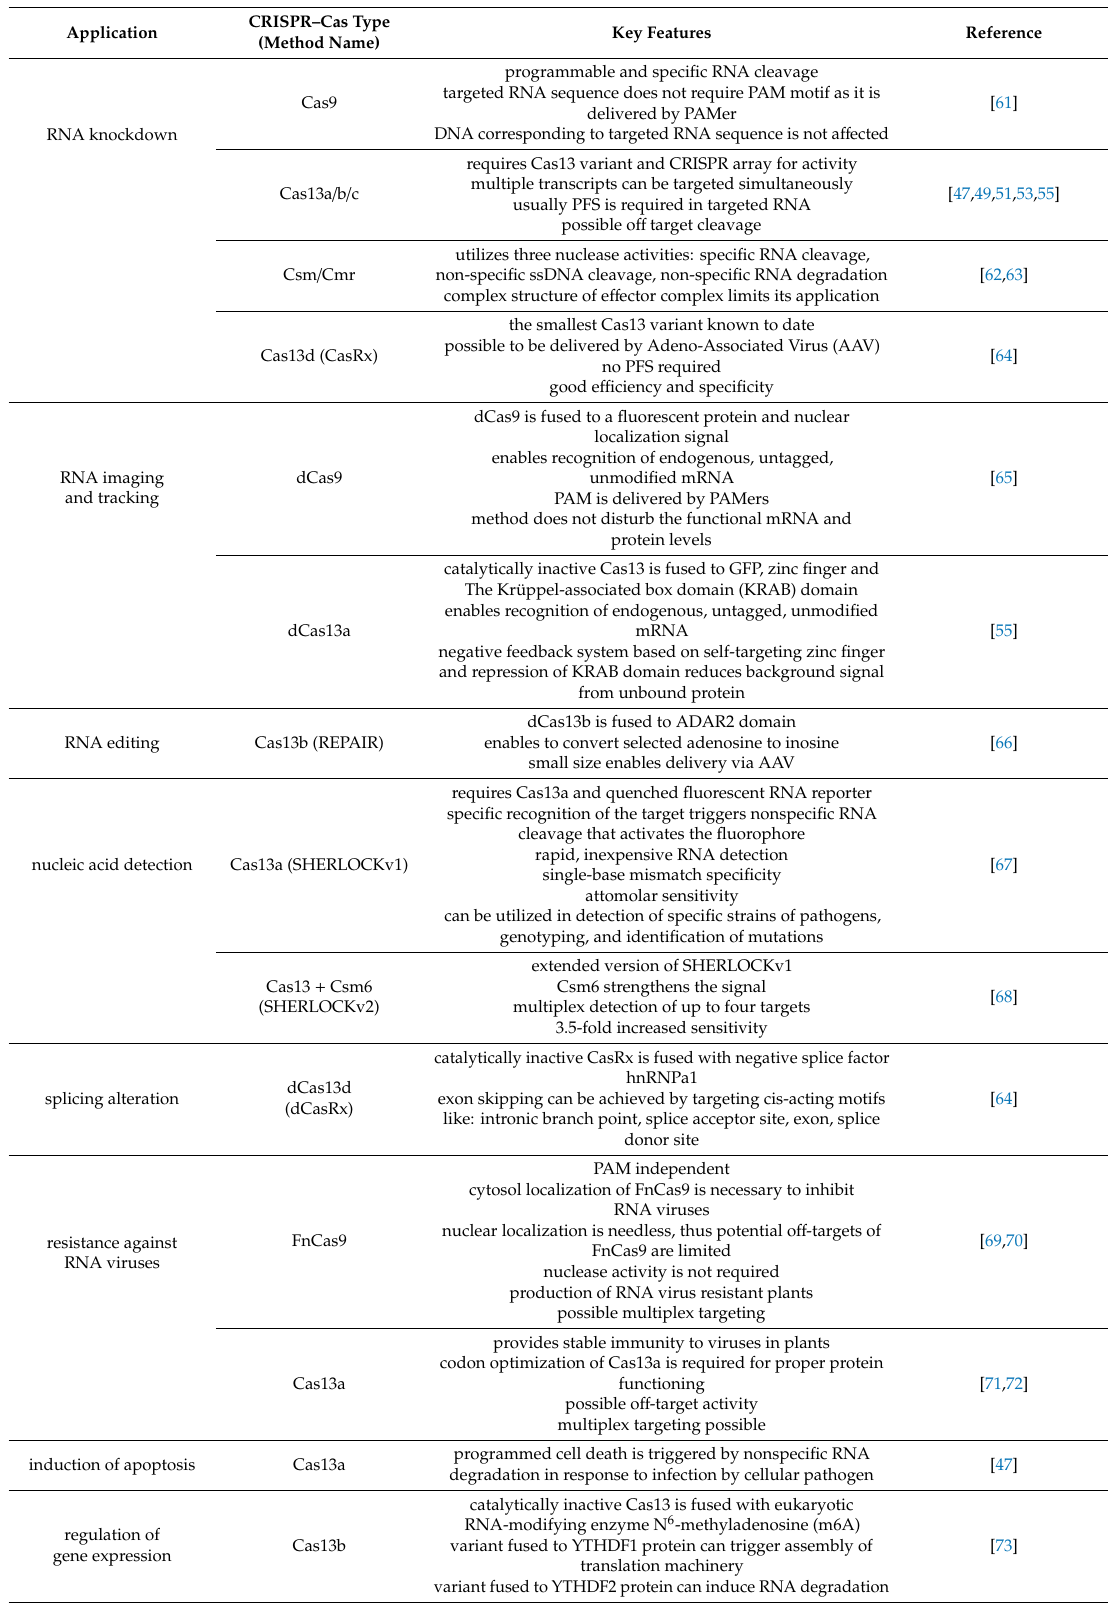
Table 1. Applications based on RNA-targeting CRISPR–Cas